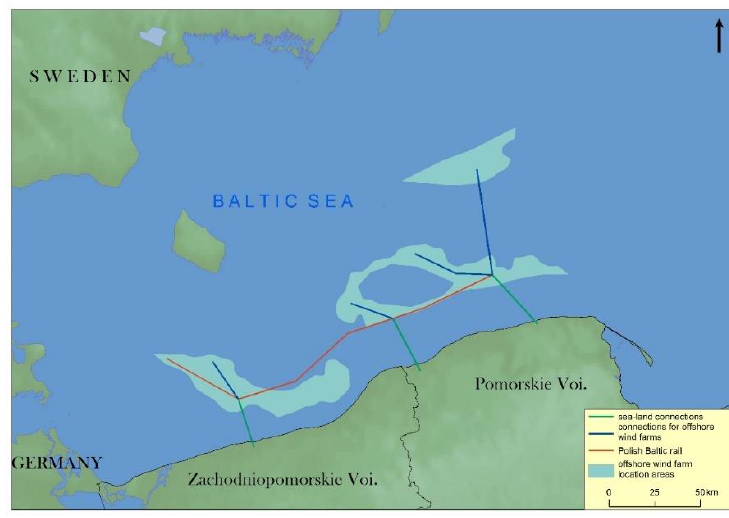
Figure 6. Potential locations of offshore wind farms in Poland (own study from [93]).